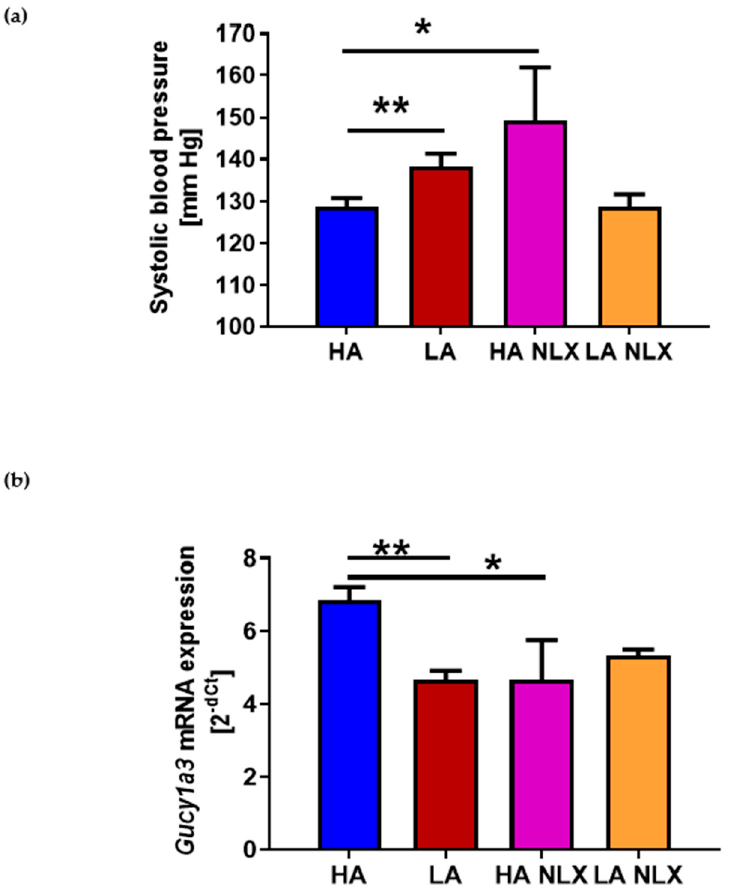
Figure 4. ( a ) Systolic blood pressure in HA and LA mice in basal conditions ( n = 25–27) and after naloxone treatment ( n = 4); ( b ) expression of guanylyl cyclase mRNA in aortas of HA and LA mice ( n = 8) and HA and LA mice treated with naloxone ( n = 4); * p < 0.05, ** p <